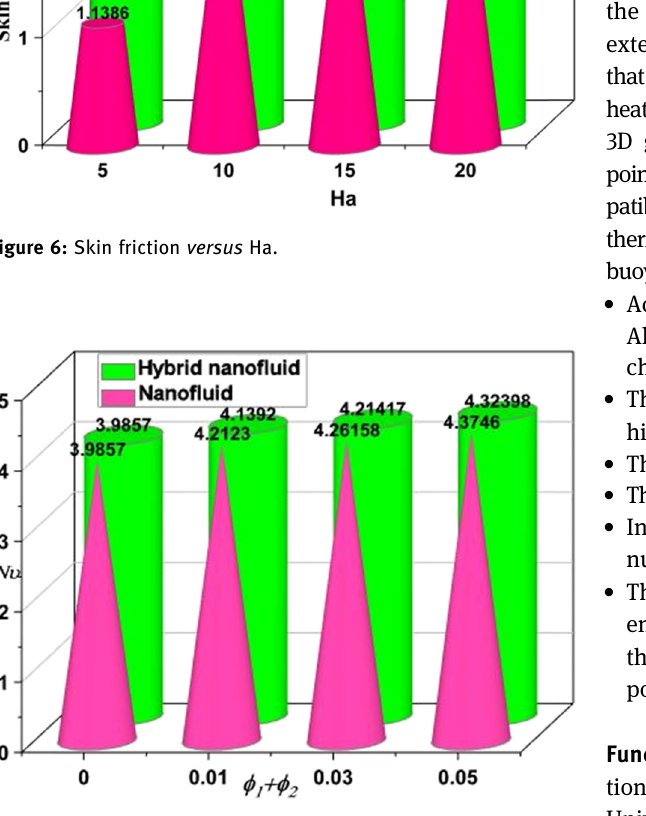
Figure 7: Nusselt number versus volume fraction.